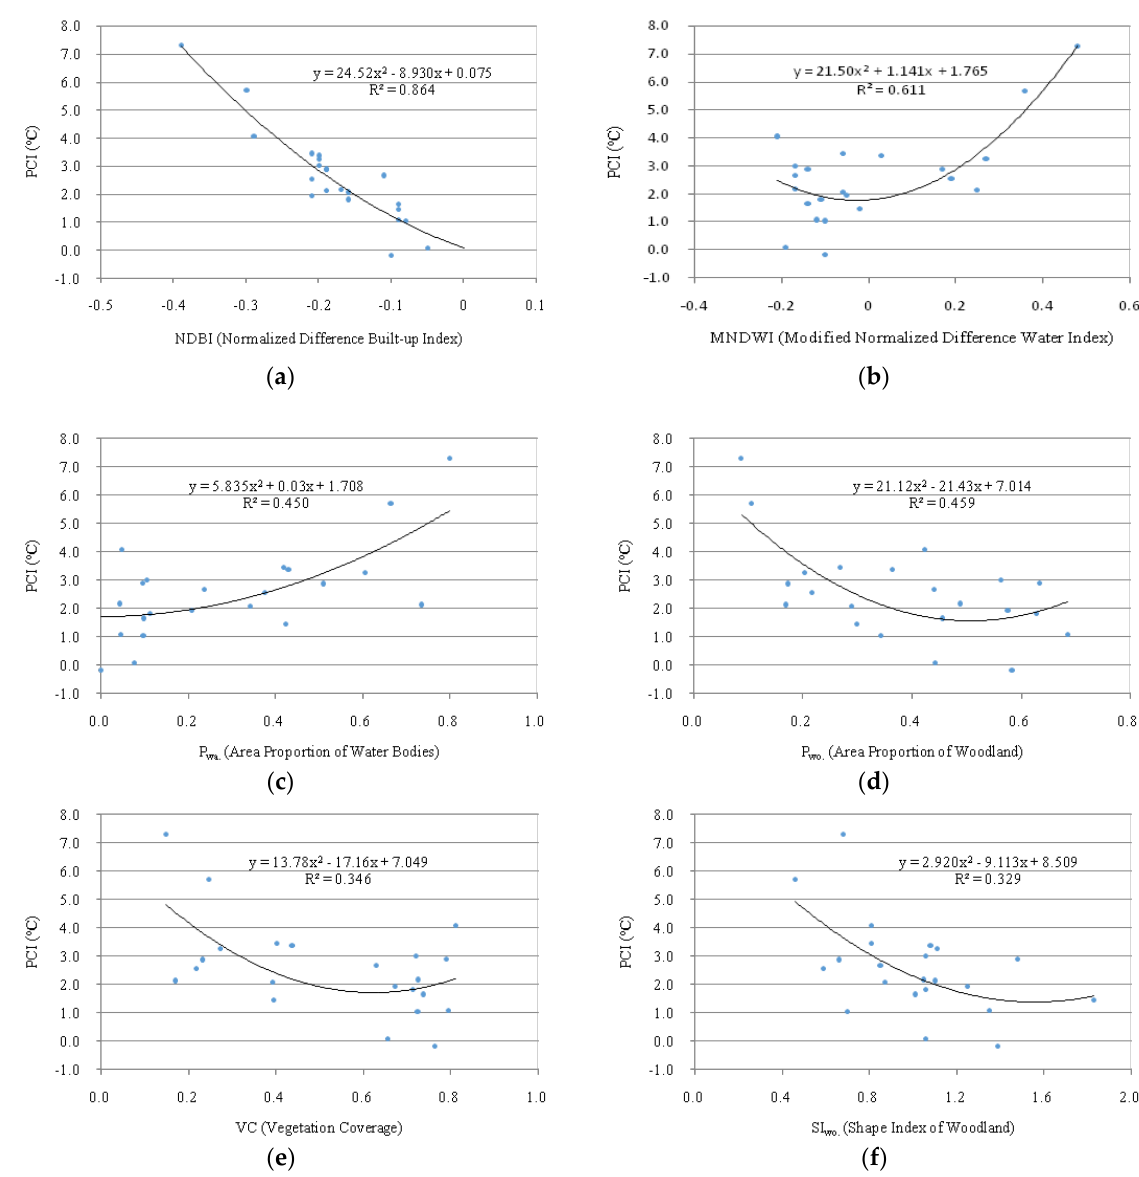
Figure A1. Correlations among PCI and the main variables. ( a ) NDBI (normalized difference built-up index), ( b ) MNDWI (modified normalized difference water index), ( c ) P wa. (area proportion of water bodies), ( d ) P wo. (area proportion of woodland), ( e ) VC (vegetation coverage), and ( f ) SI wo. (shape index of woodland). Table A1. Pearson correlationsamongthe PCIvalues and all variables indicating park structure characteristics. PCI